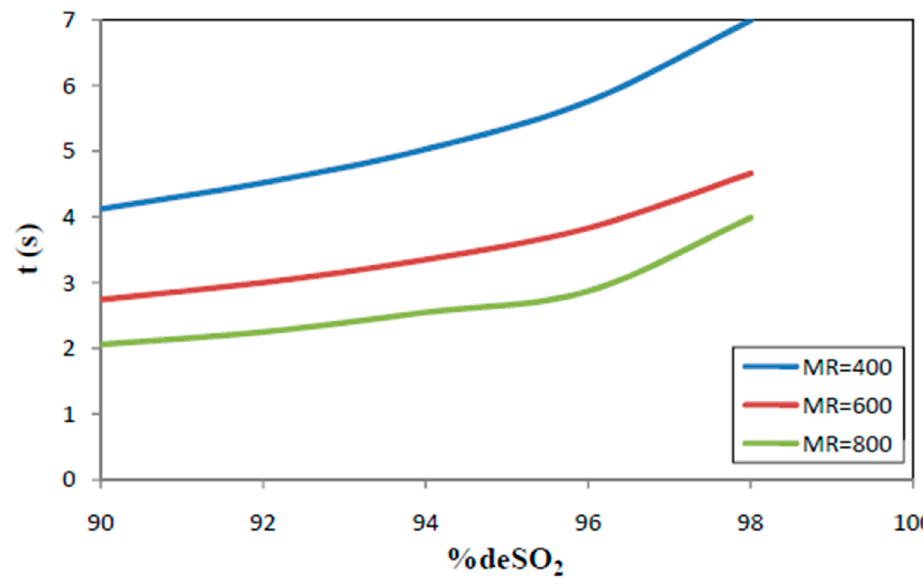
Figure 10. Predicted required reaction time for a given de-SO 2 efficiency, at various values of M R (1125K, k g = 300 m / s, D e = 10 − 7 m 2 / s.).